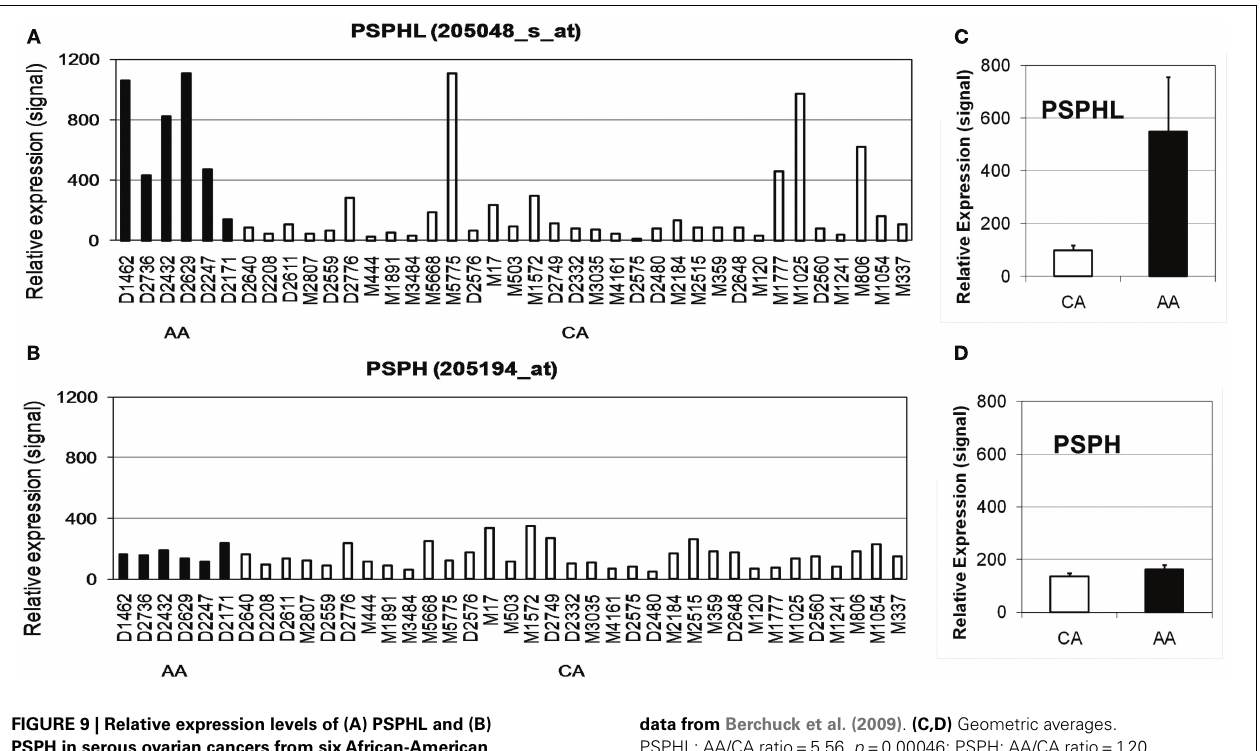
FIGURE 9 | Relative expression levels of (A) PSPHL and (B) PSPH in serous ovarian cancers from sixAfrican-American (AA) and 33 Caucasian (CA) women estimated using array